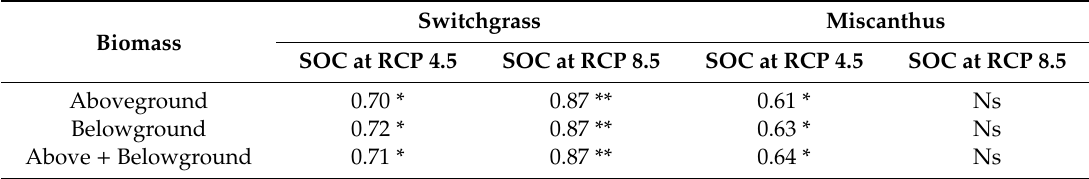
Figure 3. Average decadal switchgrass and miscanthus below and aboveground biomass production predicted by DayCent over the 21st century at two representative concentration pathways: ( a ) RCP 4.5 and ( b ) RCP 8.5. Error bars represent confidence level for sum above and below ground biomass at p = 0.05. Table 5. Pearson correlation coefficients between above and below biomass and SOC stocks (ns = non-significance).